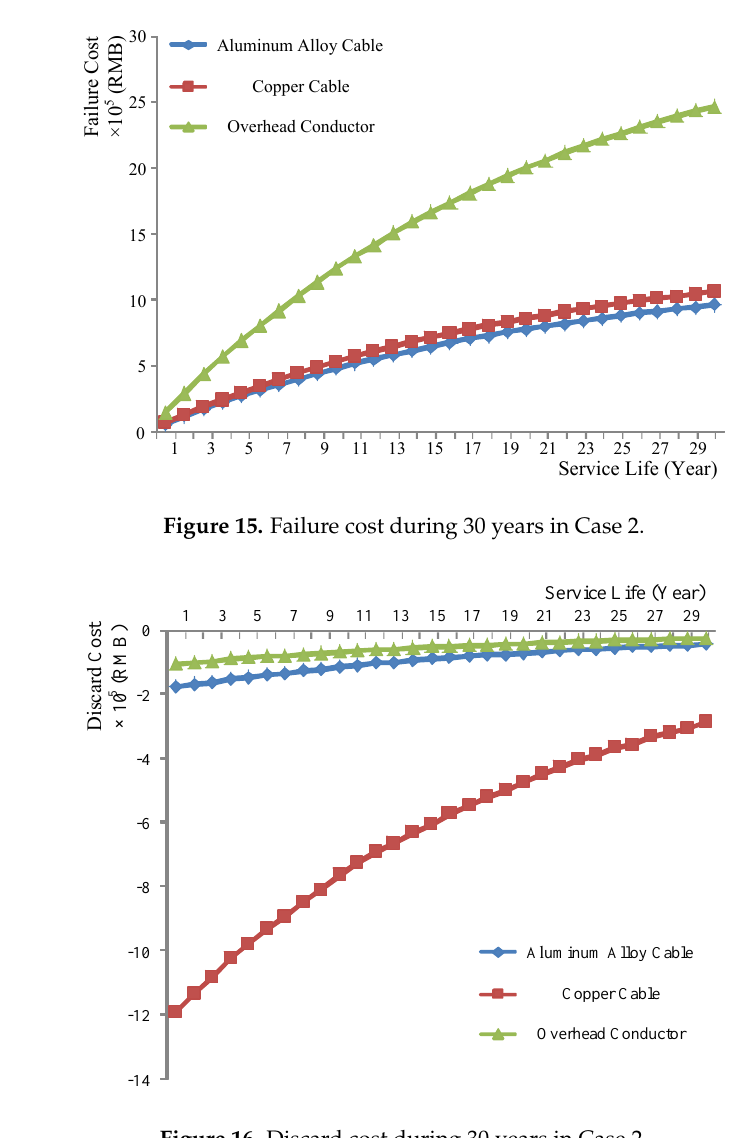
Figure 16. Discard cost during 30 years in Case